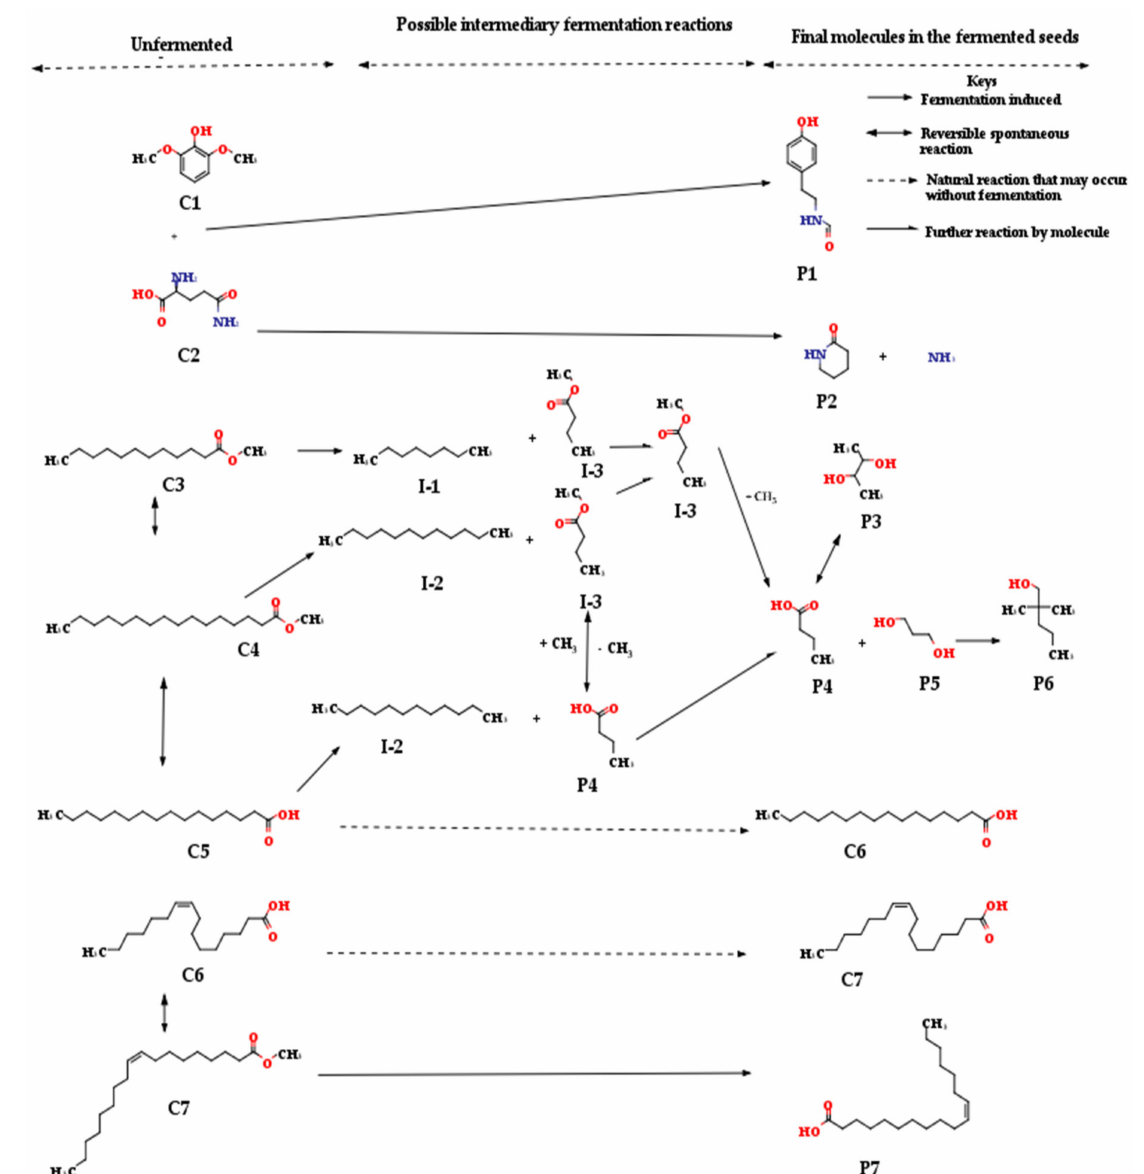
Figure 2. The proposed mechanisms for the transformation of major molecules identified in the natural kernels of T. catappa during fermentation. Keys: P1 : Formamide, N-(p-hydroxyphenethyl) (2.80%); P2 : 2-Piperidinone (6.63%); P3 : Butane- 2,3-diol (1.81%); P4 : Butyric acid (16.20%); P5 : Propane-1,3-diol (19.66%); P6 : Neoheptanol (2.89%); P7 : Cis-vaccenic acid (1.69%); I-1 : Octane; I-2 : Dodecane; I-3 : Methyl butanoate; C1 : Syringol (6.03%); C2 : Glutamine (1.71%); C3 : Methyl laurate (1.79%); C4 : Methyl palmitate (1.53%); C5 : Palmitic acid (5.20%); C6 : Palmitoleic acid (2.80%); C7 : Methyl oleate